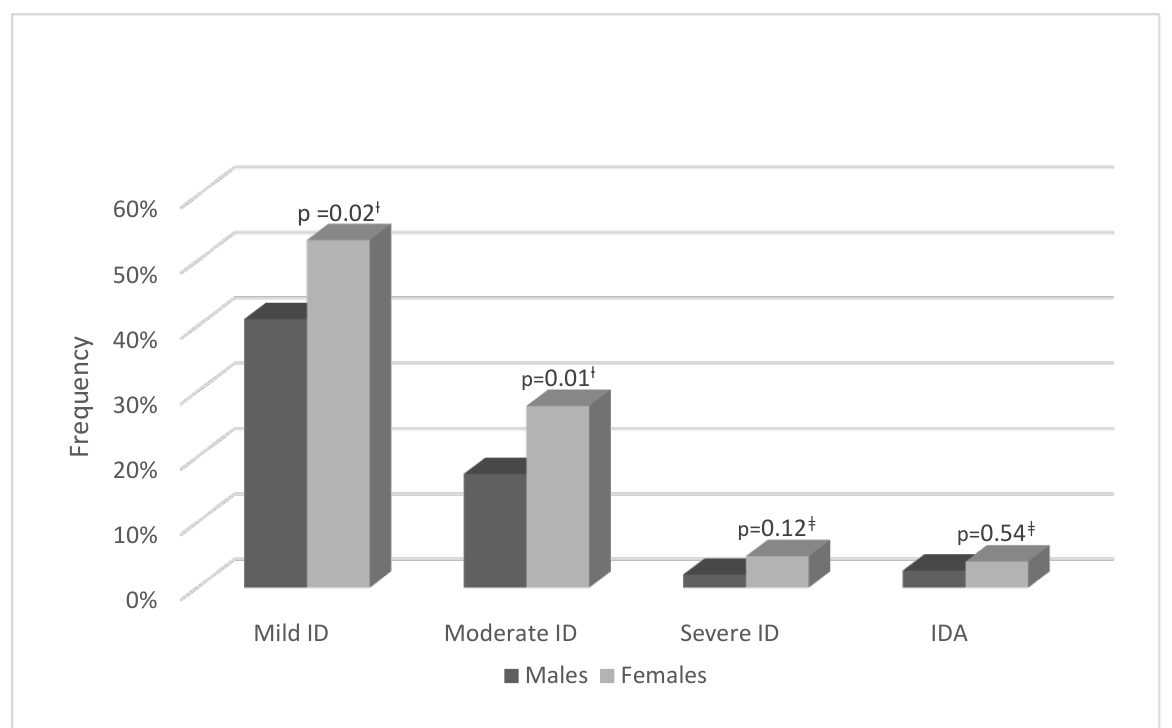
Figure 1. Males’ and females’ iron deficiency and iron deficiency anemia frequencies and a comparison between gender groups . Mild ID = sFer ≤ 30 µg/L; moderate ID = sFer ≤ 20 µg/L; severe ID = sFer ≤ 10 µg/L. IDA = sFer ≤ 20 µg/L and Hb < 13 g/dL or Hb < 12 g/dL for males and females, respectively. ID and IDA were calculated with a 95% confidence interval. † Indicates the use of χ 2 test. ‡ Indicates the use of Fisher’s exact test.